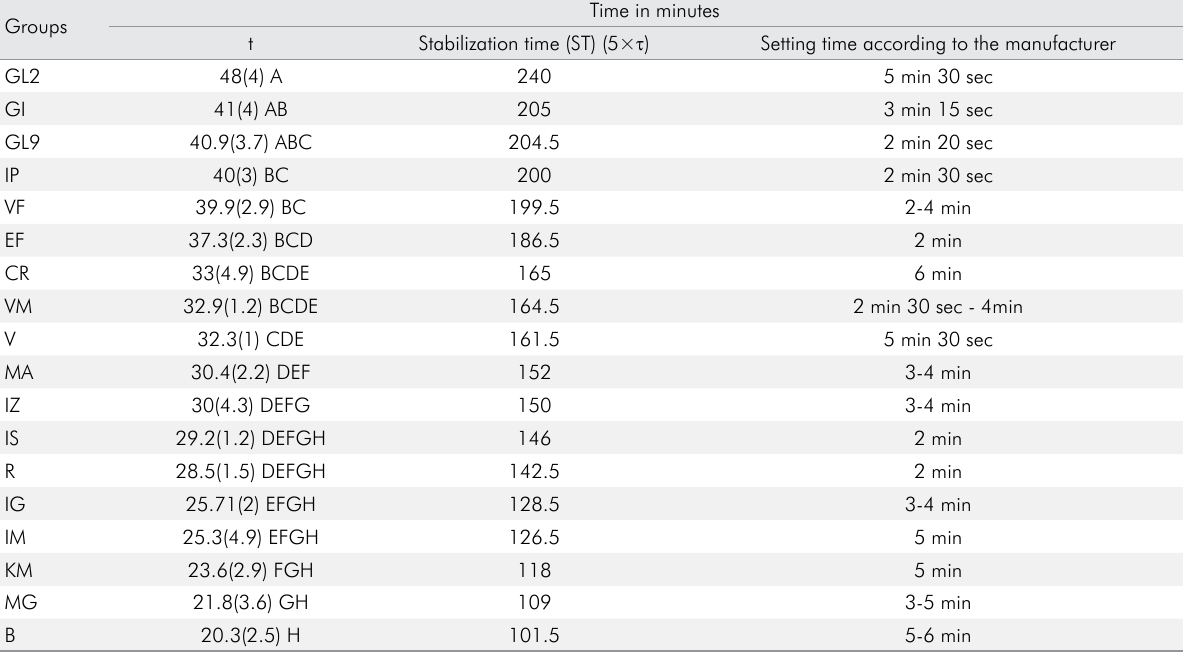
Table 2. Means and standard deviations of the time required to stabilize the chemical reactions of the GICs. Groups